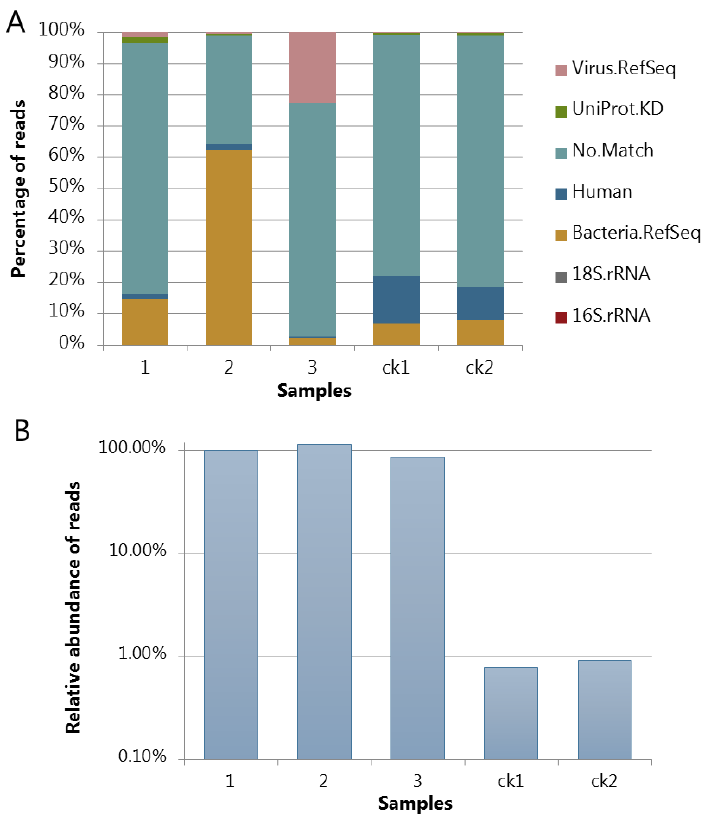
Figure 4. ( A ) Distribution of sequencing reads into the different taxonomic categories viral, human, bacterial, and unknown origin. To check the presence of non-viral DNA sequences, 50,000 random forward reads were evaluated according to their match to a range of viral, bacterial, and human reference genome and protein databases as described in [17]. No reads (in 50,000 reads) matched to the 16S rRNA gene sequences in all the samples. ( B ) Relative abundance of sequencing reads matching the assembled virus-like contigs compared to the average of the three true samples. At least 10 times coverage / contig was applied here as the threshold for counting. Numbers 1–3refer to viromes extracted from feces from infants 1–3. ck1 and ck2 refer to co-extracted blank (SM bu ff er)